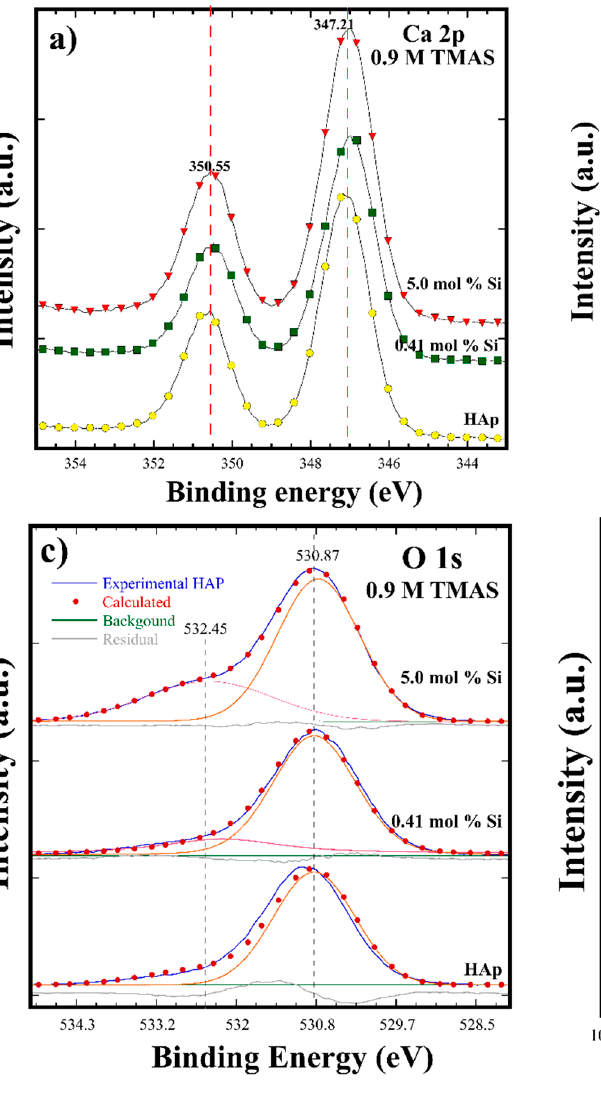
Figure 5. The XPS analysis for HAp and Si-HAp powders obtained by microwave assisted hydrothermal process at 150 °C for 1 h using 0.9 M of TMAS and different mol% of Si: ( a ) Ca 2p; ( b ) P 2p; ( c ) O 1s; ( d ) Si 2p.